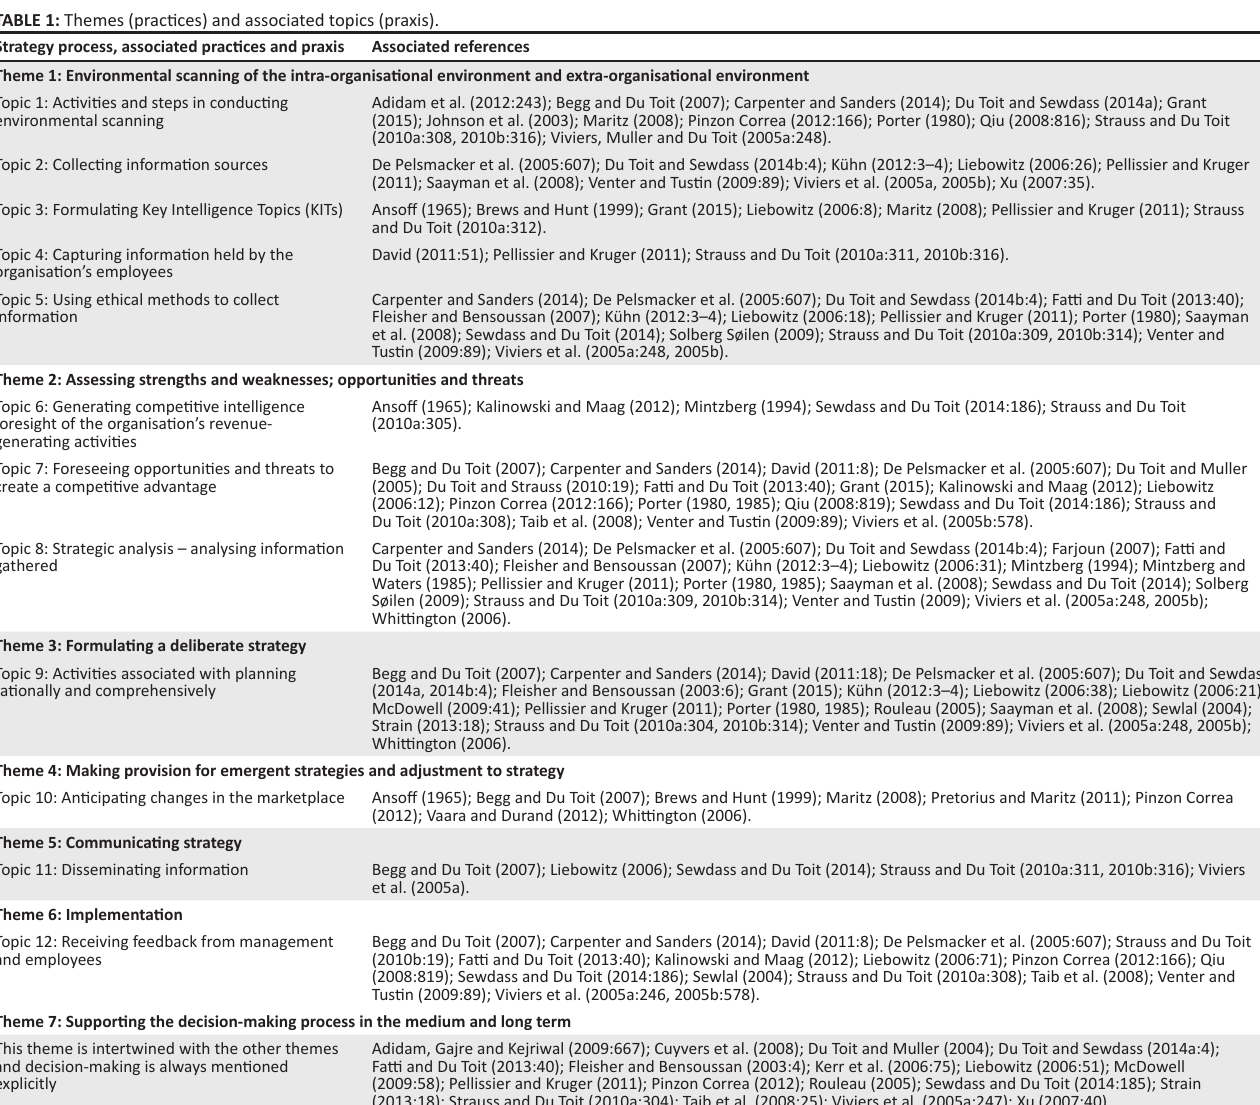
TABLE 1: Themes (practices) and associated topics